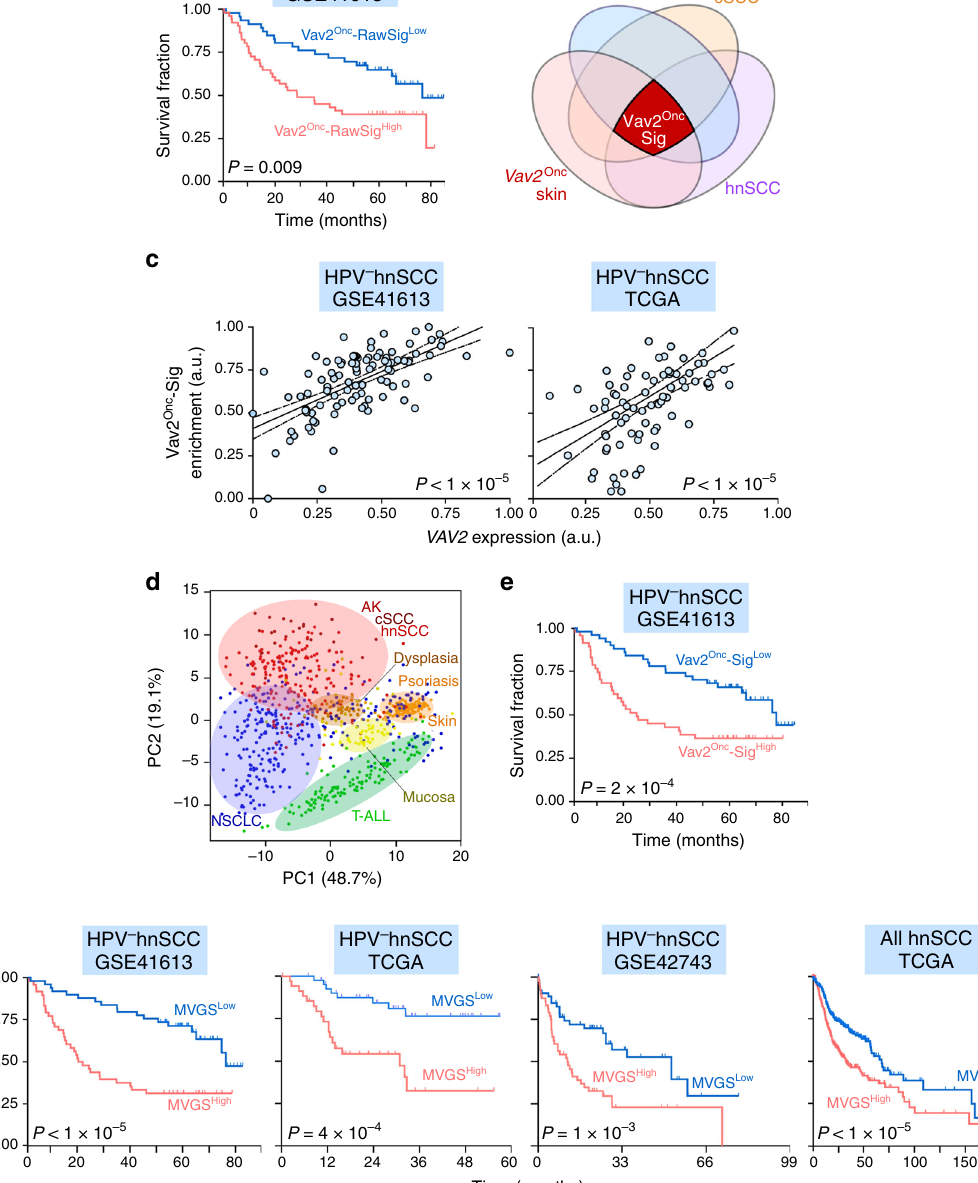
Fig. 10 A prognostic Vav2 Onc -regulated gene signature for HPV – hnSCC. a Survival of HPV − hnSCC patients ( n = 97) according to the expression of the raw Vav2 Onc -driven transcriptome. The Mantel – Cox test P value is indicated. b Venn diagram representing the criteria used to select the Vav2 Onc -Sig (dark red color). The datasets used include: the Vav2 Onc -driven transcriptome ( Vav2 Onc skin), the Vav2 – / – ;Vav3 – / – - dependent fraction of the transcriptome induced by TPA (12-O-tetradecanoyl-phorbol-13-acetate) in the mouse skin ( Vav2 – / – ; Vav3 – / – + TPA skin), and the human cSCC- and hnSCC-associated transcriptomes. c Correlation between VAV2 mRNA levels and the enrichment of the Vav2 Onc -Sig in the indicated gene expression datasets (top). The P value of the F-test assessing the signi fi cance of the non-zero slope is indicated. d Principal component analysis showing the enrichment of the Vav2 Onc - Sig across the indicated tumor-associated transcriptomes. NSCLC, non-small cell lung cancer; T-ALL, T-cell acute lymphoblastic leukemia. e Survival of HPV – hnSCC ( n = 97) patients according to the levels of the Vav2 Onc -Sig present in tumors. The Mantel – Cox test P values obtained in each analysis are indicated. f Survival of hnSCC patients according to levels of the MVGS (minimal Vav2 Onc gene signature) using the indicated datasets (top). The Mantel – Cox test P values obtained in each analysis are indicated. In a , c , e , and f , the datasets used for the in silico analyses are shown on top of each graph. Source data for this fi gure are provided as a Source Data fi le. light brown), the large majority of non-small cell lung cancer Vav2 Onc -Sig can stratify HPV – hnSCC patients according to patient samples (Fig. 10d, area shaded in light blue), and unre- long-term survival criteria with better resolution (Fig. 10e, P = lated tumors such as T cell acute lymphoblastic leukemia 2.4 × 10 – 4 ) than the abundance of the VAV2 mRNA (Fig. 1b, P = 0.0079) and the overall Vav2 Onc -regulated transcriptome (Fig. 10d, area shaded in light green). When tested prognostically (Fig. 10a, P = 0.0092). Similar results were found using the cohort using the GSE41613 gene expression dataset, we observed that the NATURE COMMUNICATIONS| (2020) 11:4788